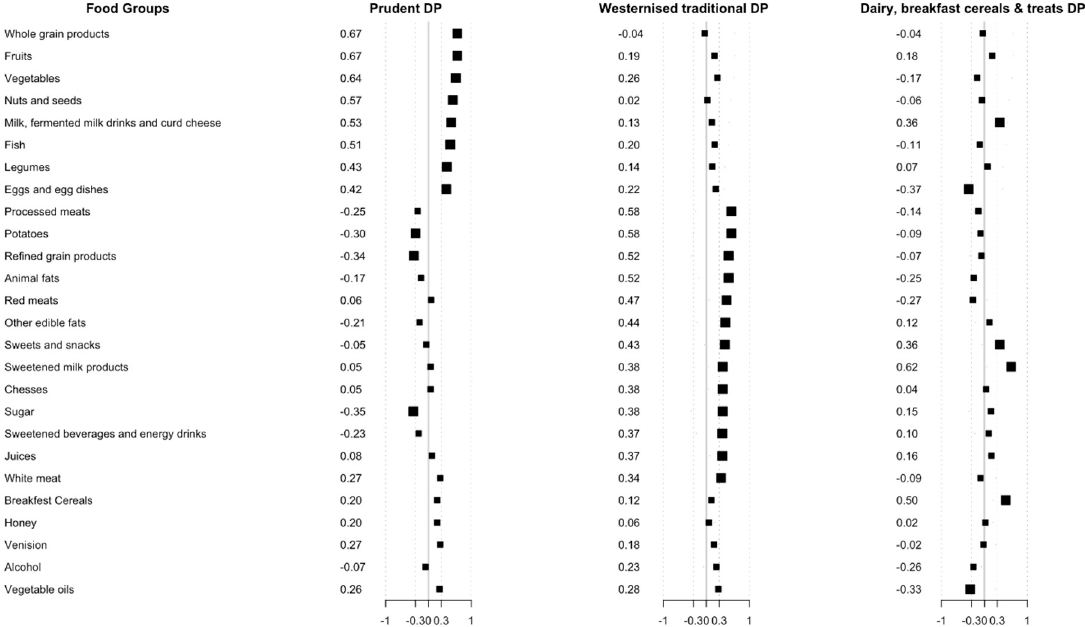
Figure 2. Factors loadings for the three dietary patterns (DPs) identified by principal component analysis. The larger squares represent items with factor loading ≥ analysis. The larger squares represent items with factor loading ≥ |0.3|.